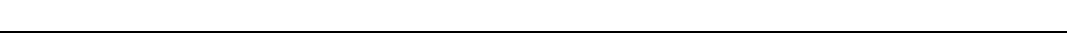
Fig. 3 The bone marrow within the imaging volume reaches steady-state comparable to homeostasis 28 days after LIMB implantation. a Immuno fl uorescence analysis of bone sections after removal of the LIMB implant over the time course of 4 weeks. ECM formation was identi fi ed by the marker Laminin (Lam). Stem-cell antigen 1 (Sca-1) is highly expressed in arterioles. The leukocyte marker CD45 indicates localization of in fl ammatory cells adjacent to the window cavity (wc). Lam is highly expressed around the implant during the fi rst week and completely normalizes after 2 – 4 weeks. CD45 + cell accumulations are found during the fi rst weeks in proximity to the wc. b Movat ’ s pentachrome stain detects connective tissues and reveals remodeling of bone primarily on the periosteal interface near the fi xation plate. a , b Images are representative for 3 – 5 mice per time point post-surgery. c Overview immuno fl uorescence images of the femoral bones from an individual mouse 3 days post-surgery. Note the speci fi c reaction to the implant-bone marrow interfaces indicated by accumulations of CD45 + cells, and Lam + and Sca1 + arteries (yellow). bm bone marrow, cb cortical bone. d Immuno fl uorescence image of the region around the endoscope tubing in a LIMB-implanted femur 7 days post-surgery, including the bone cortex and periosteum under the plate. The presence of various blood vessel subsets indicated by CD31 and Emcn demonstrates intact blood supply to the periosteum and to the bone. Scale bar = 100 µ m. e Blood supply is intact throughout the marrow cavity, indicated by CMTPX-labeled splenocytes, which localize in the bone marrow 4 h after transplantation in both contralateral and LIMB-implanted femurs at 42 days post-surgery ( n = 3 mice). f Histological DAPI stain (gray) shows intact tissue structure, with no separation of the bone marrow and the vasculature by the screws or endoscope tubing. g Flow cytometry analysis of femurs with the LIMB implant, their contralateral femurs and femurs of control mice. Similar frequencies and cell counts of various cell populations shows no effect of the LIMB implant on bone marrow cell composition ( n = 8 LIMB-implanted mice, n = 8 controls, two independent experiments). Error bars represent s.e.m. values. Statistical analysis was performed using t